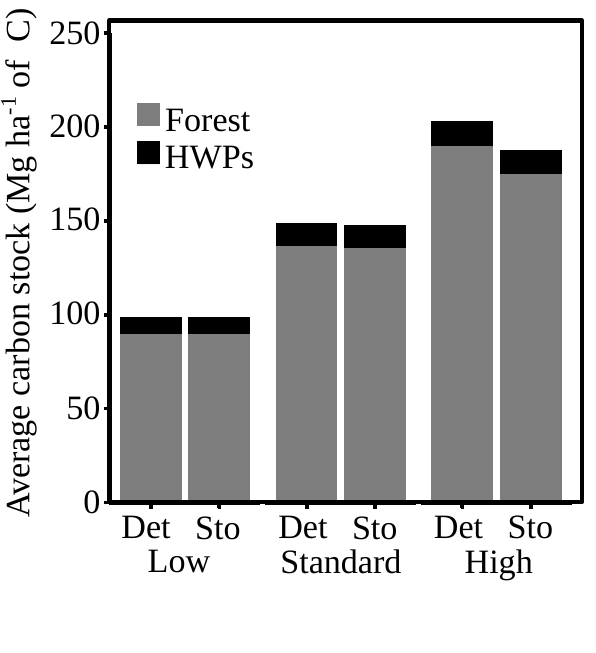
Rotation-averaged carbon stocks in the forest and the HWP carbon pools under deterministic (Det) simulations without storm damage considered, and stochastic (Sto) simulations including storm damage for the three forest management scenarios (Low, Standard and High densities). For stochastic simulations, the values are the averages of the 1000